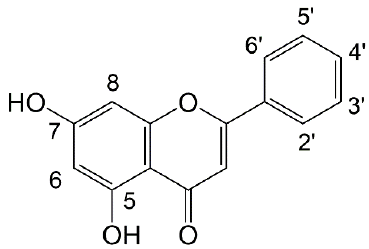
Figure 6. The chemical structure of flavones, it is known that hydroxylation at positions 2′ , 4′ - or 2′ , 6′ - on ring B and 5,7 on ring A plays an important role in antibacterial activity. However, the antibacterial activity of gambir extract was reported by activity against Escherichia coli O157:H7. In this study, the aqueous extract of gambir did not have an antibacterial effect, but the ethanol extract produced an inhibition zone. Kresnawaty and Zainuddin [74] later also reported that ethanol extract has the antibacterial activity of Escherichia coli . In the research by Melia et al. [75], gambir was extracted with ethyl acetate as a solvent, and the antioxidant and antimicrobial activity of gambir extract were investigated. The results showed that ethyl acetate extract from gambir could inhibit the growth of S. aureus (Gram-positive bacteria), E. coli , and Salmonella sp . (Gram-negative bacteria). Magdalena and Kusnadi [76] tested the antibacterial activity of gambir extracted using the microwave method. The results showed that the antibacterial activity based on the diameter of the inhibition was E. coli ATCC 25922 of 12.07 mm, Salmonella typhimurium of 12.57 mm, S. aureus of ATCC 29213 of 13.99 mm, and Bacillus cereus of 14.38 mm. To determine the main compounds that play a role in antibacterial activity, Musdja et al. [77] compared the inhibitory activity between (+)-catechins and gambir extract. The (+)-catechins were extracted from gambir using thin-layer chromatography. The antibacterial test was carried out by microdilution against S. epidermidis , S. aureus , S. mutans , S. viridans , and Bacillus subtilis bacteria. The results showed that catechins showed significant activity compared to the gambir extract. The minimum inhibitory concentration values for S. epidermidis , S. mutans , and S. viridans were 5.5; 8; and 8 mg/mL, respectively. In this study, it was also known that the antibacterial activity of (+)-catechins and gambir caused damage to plasma cell membranes and nucleoid coagulation. 4.1.3. Anti-Helmintic Helminth parasites are parasitic worms from the phyla Nematoda (roundworms) and Platyhelminthes (flatworms) [78]. Helminths are the most common infectious agents among humans in developing countries and produce diseases such as malaria and tuberculosis [79]. Between 30 and 40% of the estimated 1.4 billion people living in poverty are in sub-Saharan Africa, where helminth disease rates are also the highest [80]. Helminth disease in the human population occurs mostly in marginalized, low-income, and resource-limited areas of the world, with more than 1 billion people in developing regions of Africa, Asia, and the Americas infected with one or more types of helminths. This infection creates a burden of disease that contributes to poverty, decreased productivity, and inadequate socioeconomic development [81]. The anthelmintic potential of the ethyl acetate fraction of the alcoholic extract from the leaf and shoot of gambir showed effective anthelmintic activity against adult Indian earthworm ( Pheretima posthuma ). The extract was tested on Indian adult earthworm in vitro, and the increases in paralysis time and worm death time showed the effectiveness of gambir as a natural anthelmintic [82]. In another study, both leaf and shoot extracts were found to have anthelmintic properties in a dose-dependent manner [83]. Tannins